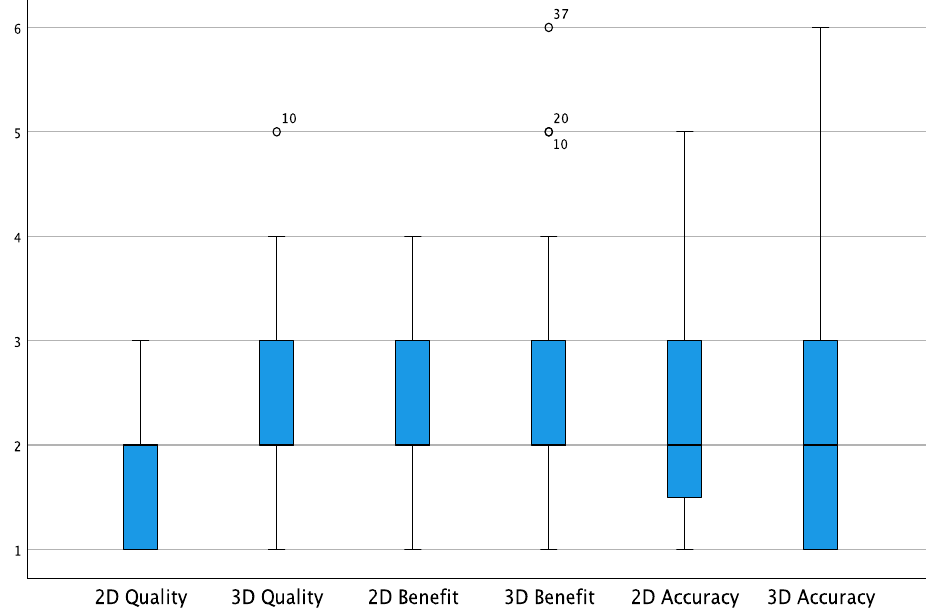
Figure 2. Box plot showing the overall values for quality, benefit and accuracy (Likert scale). White circles = low potential outlier (more than 1.5 inter-quartile range at most 3 inter-quartile